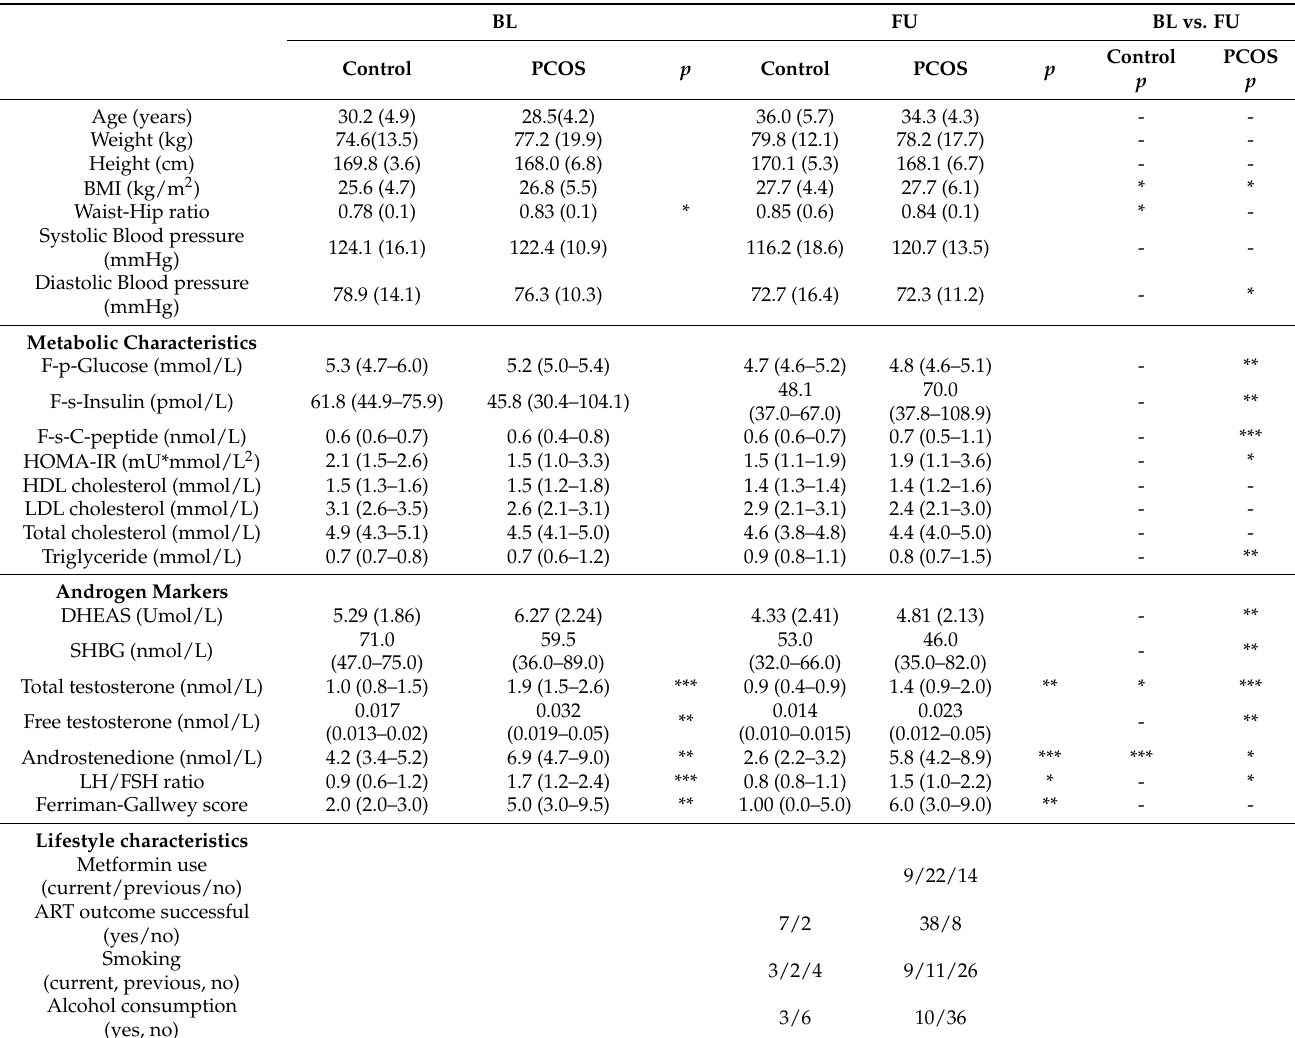
Table 1. BL and FU characteristics of the study participants. Data are represented as means (SD) or as medians (interquartile range) if not normally distributed. * p < 0.05, ** p < 0.01, *** p < 0.001. BL FU BL vs. FU Control PCOS p Control PCOS